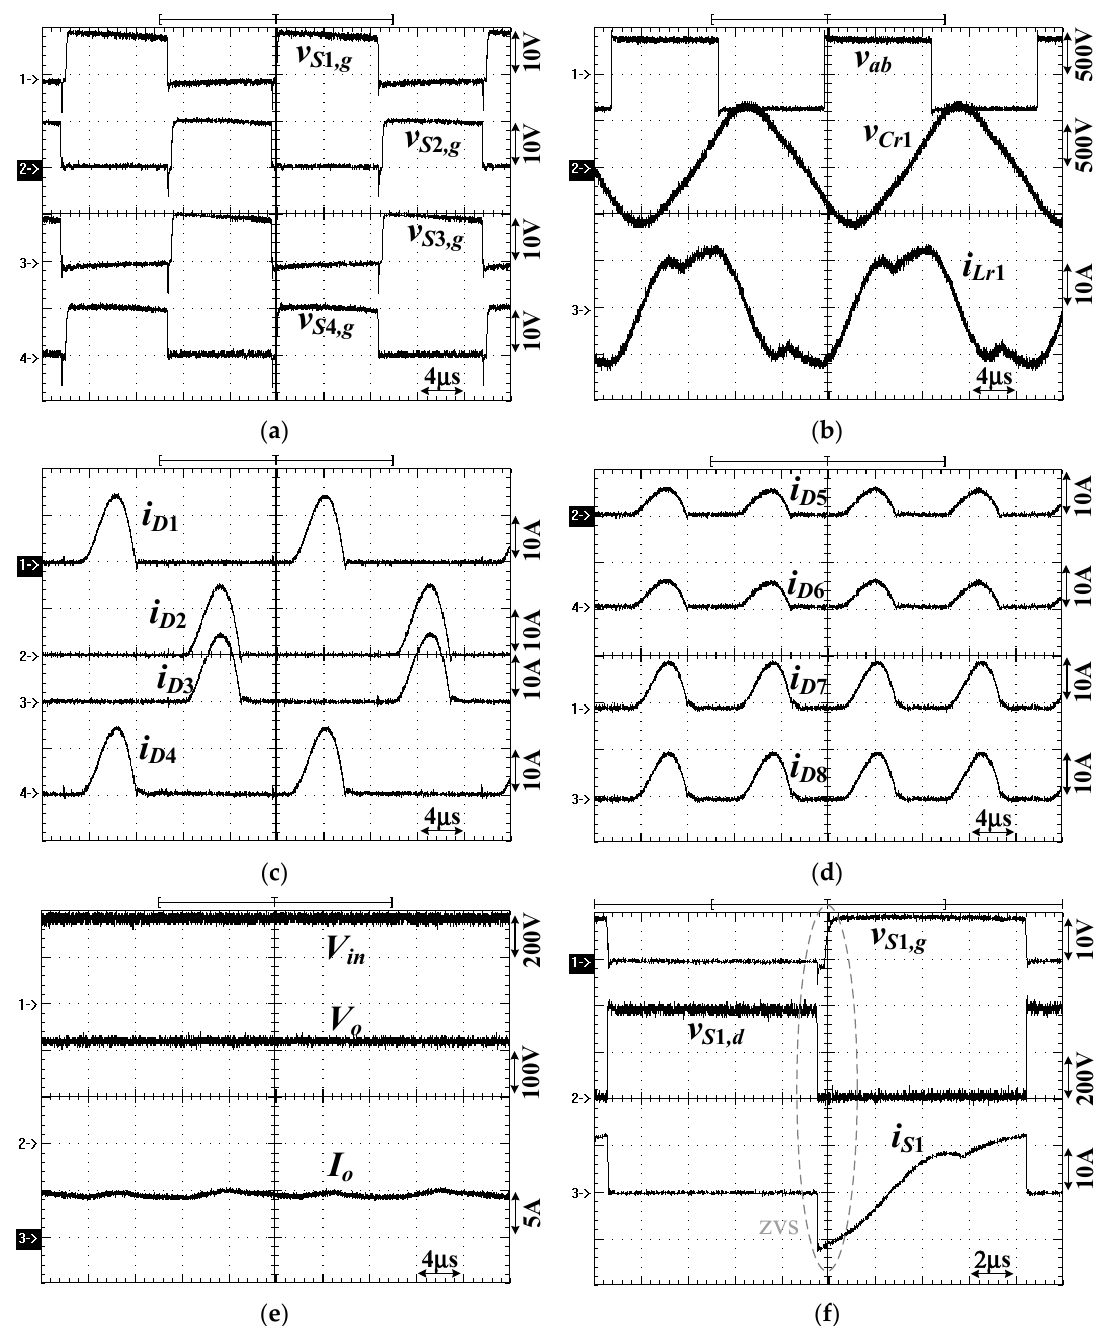
Figure 8. Measured results at 215 V output and 1 kW load under the low output voltage range. ( a ) PWM signals v S 1, g ~ v S 4, g ; ( b ) v ab , v Cr 1 , i Lr 1 ; ( c ) diode currents i D 1 ~ i D 4 ; ( d ) diode currents i D 5 ~ i D 8 ; ( e ) V in , V o , I o ; and ( f ) v S 1 ,g , v S 1 ,d , i S 1 .